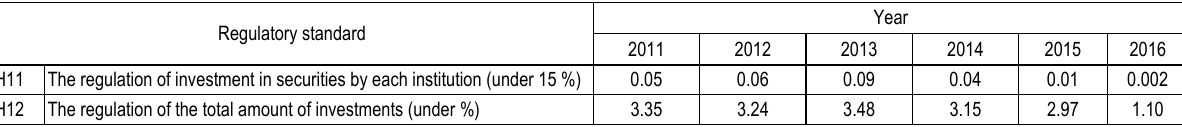
Table 4. Values of the investment regulatory standards of the National Bank of Ukraine on average within the banking system in the period of 2011-2016 *